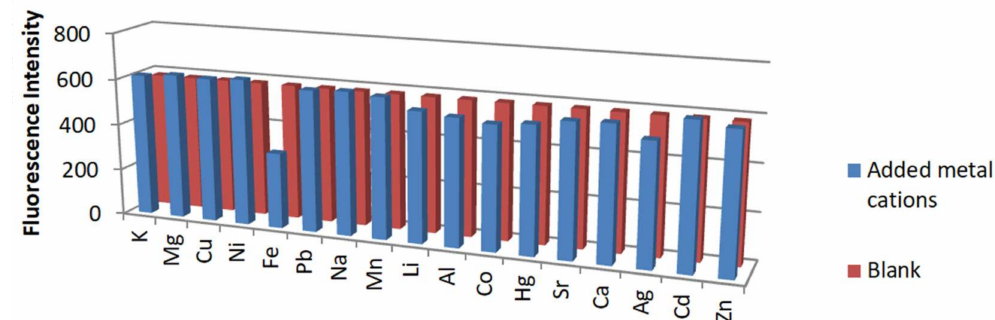
Figure 3. Fluorescence response of Rhodamine B (10 − 7 M) at 575 nm ( λ ex = 555 nm) as a function of various added metal cations (10 − 3 M) in aqueous solution of 100 mM phosphate buffer (pH 7). From left to right: K + , Mg 2+ , Cu 2+ , Ni 2+ , Fe 2+ , Pb 2+ , Na + , Mn 2+ , Li + , Al 3+ , Co 2+ , Hg 2+ , Sr 2+ , Ca 2+ , Ag + , Cd 2+ , Zn 2+ . λ ex / λ em was selected at 555/575 nm. Slit ex/em 6.0/6.0